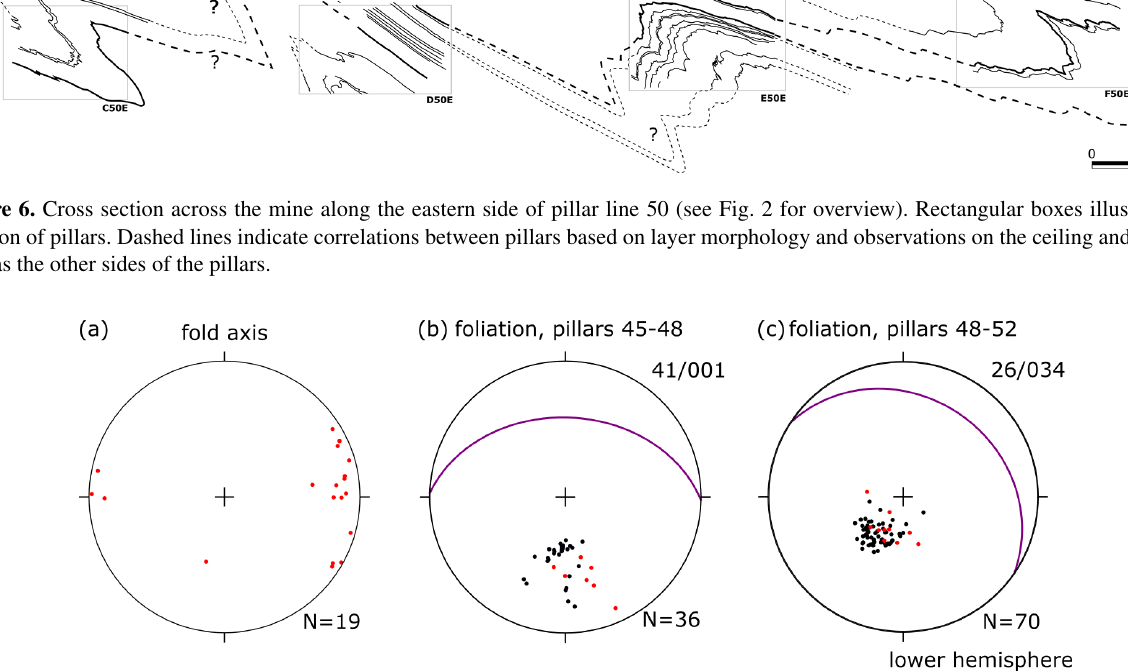
Figure 7. Lower-hemisphere stereonet plots showing (a) fold axes (all measured with the compass) and (b, c) poles to measured foliations and average orientation as a great circle. Black poles resulted from the interpretation of the 3D digital models of the mine, while the red poles were measured in the